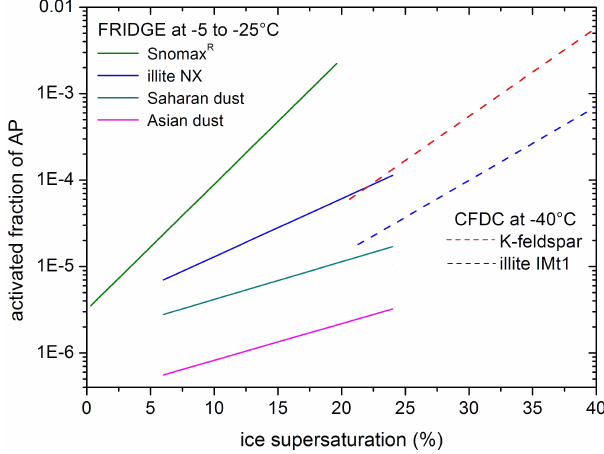
Figure 6. Activated fraction of particles in the deposition freezing mode as a function of ice supersaturation for various particle types. Regression lines based on data from K. Ardon-Dryer and Z. Levin (personal communication, 2012; Saharan and Asian dust), Yakobi- Hancock et al. (2013; K-feldspar and illite IMt1), A. Danielczok and H. Bingemer (personal communication, 2014; Snomax ® and illite NX). Described by Eq. (15) with constants in Table